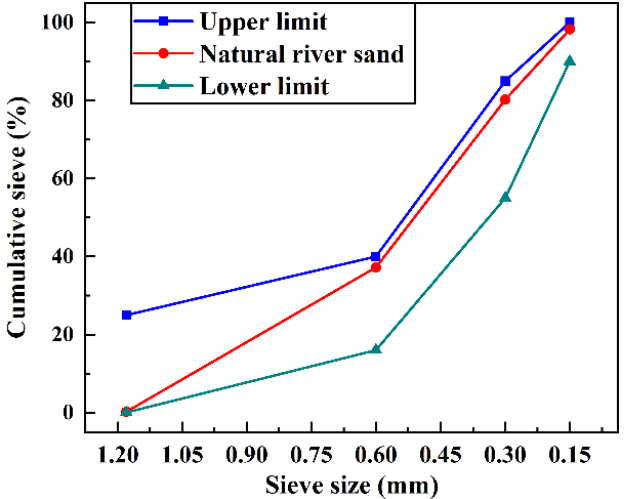
Figure 1. Gradation curve of fine aggregates used in the study. Table 1. Basic parameters of basalt fiber.